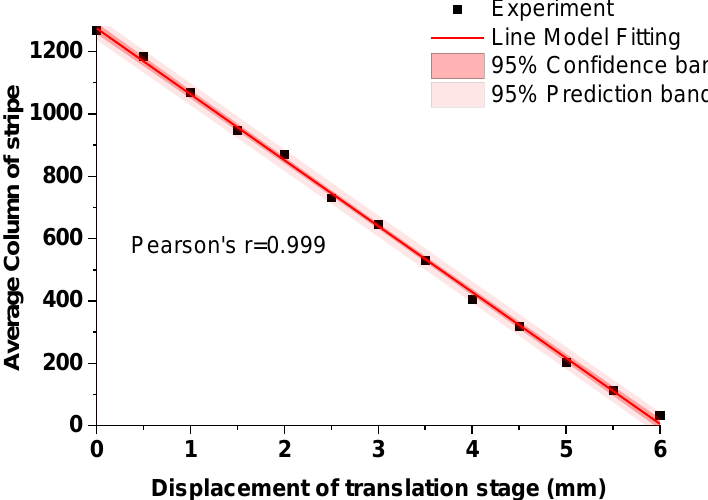
Figure 12. Calibration results of the laboratory built-prototype. Black squares represent the mean values of calculated stripe positions, red solid line is the fitting result, dark pink region represents 95% confidence band, and light pink region represents 95% prediction band.